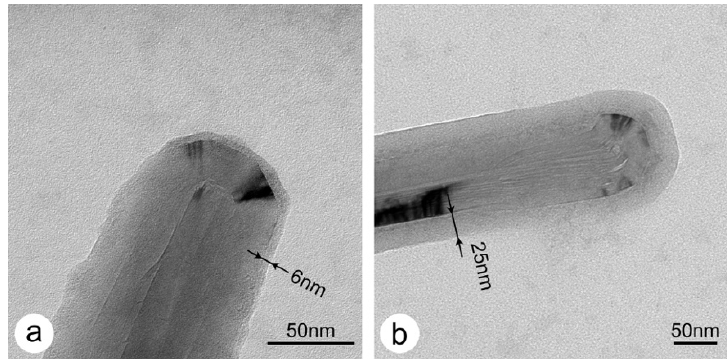
Figure 5. TEM images of silicified SbpA S-layer-coated MWNTs. ( a ) after 5 min, and ( b ) after 15 min silicification time.